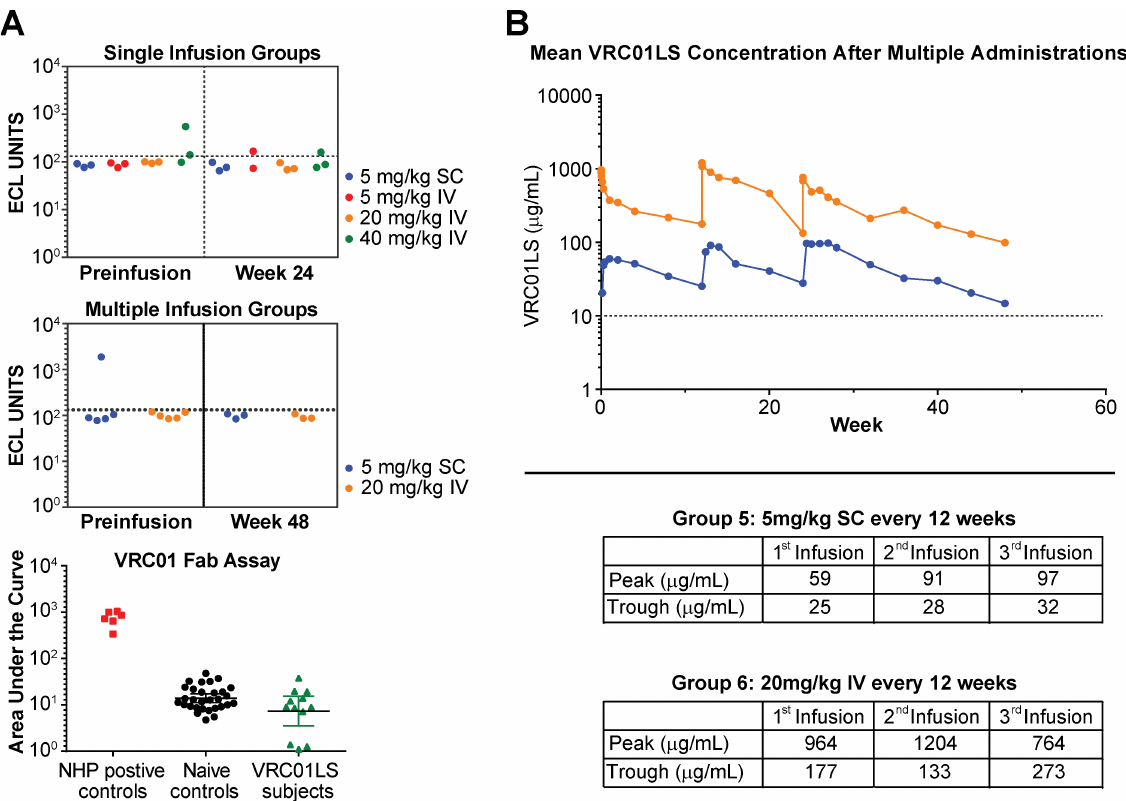
Fig 5. Evaluation of multiple administration of VRC01LS and assessment for anti-VRC01 antibodies. (A) ECL assay to assess for serum antibodiesgeneratedagainstVRC01. Data are shown for single (top panel)and multiple (middlepanel)infusion groups. The few samplesabove the ECL cutoff value (dotted line) underwent additionalanalysisusing VRC01 Fab as the antigen. These samples were comparedto positive controls obtainedfrom NHPs known to produceADA againsthuman antibodies, and negativecontrols obtained from humans who have never receivedVRC01 or VRC01LS(bottom panel). All samples were negative for ADA basedon these assays. (B) Mean serum VRC01LSconcentration followingthree administrations of 5 mg/kg SC ( n = 6 volunteers, blue line) or 20 mg/kg IV ( n = 5 volunteers, orangeline). The table insert shows the values for peak concentration assessedwithin one day after administration and trough concentrations assessed 12 weeks after each administration. The dotted line at 10 μ g/mL is shown as a reference value. ADA, antidrugantibody;ECL, electrochemiluminescence; Fab, antigen-binding fragment; IV, intravenous; NHP, nonhuman primate; SC,